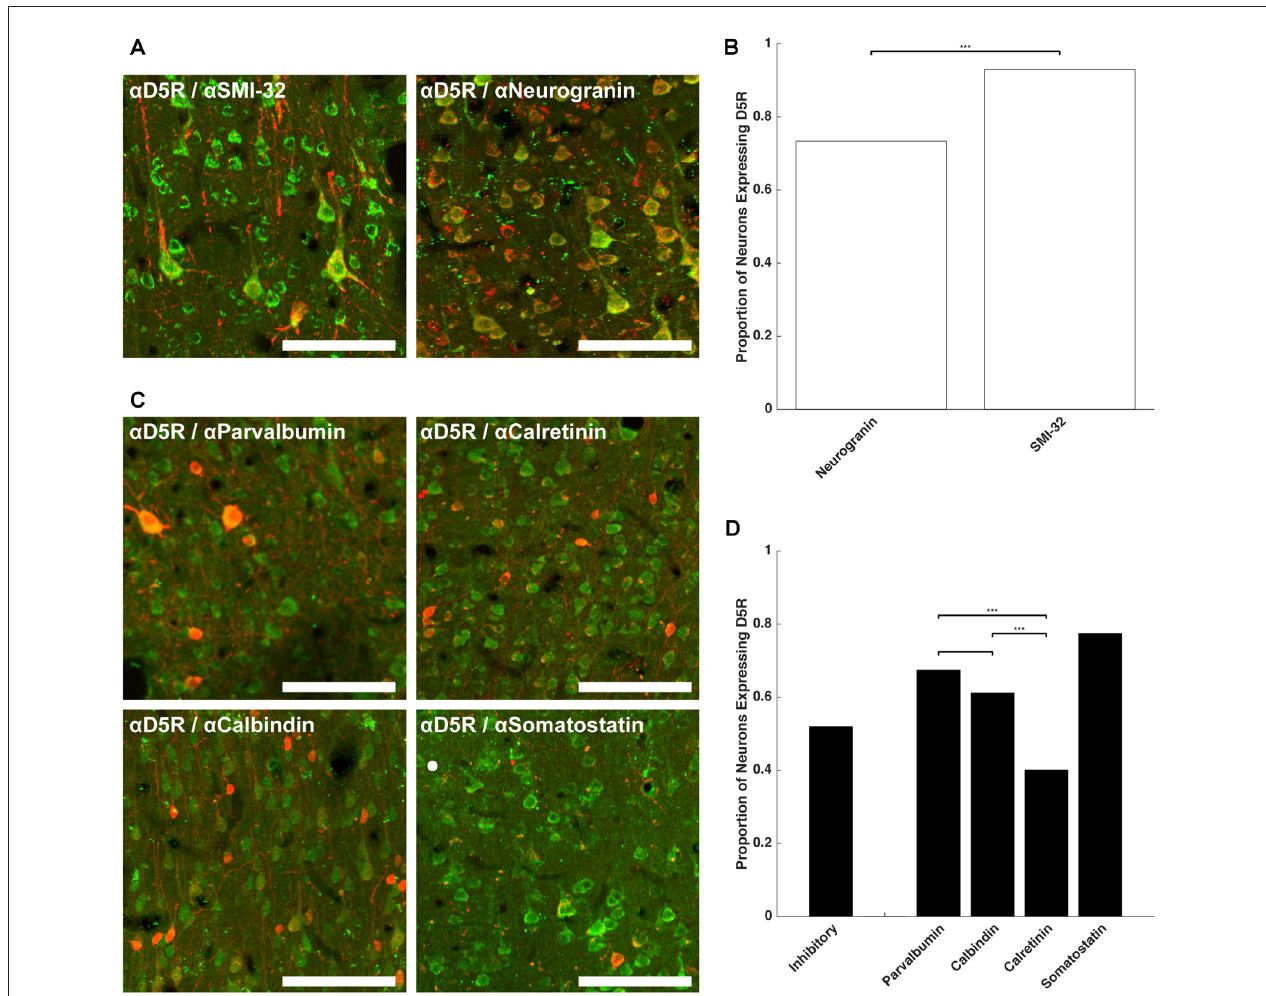
FIGURE 2 | D5R expression on different cell types. (A) Co-expression of D5Rs (green) and SMI-32+ putative long-range projection pyramidal neurons (red; left) and co-expression of D5Rs with a general pyramidal neuron stain (neurogranin, red; right). (B) Proportion of frontal eye field (FEF) SMI-32+ and Neurogranin+ neurons that express D5Rs. (C) Expression of D5Rs (green) among different interneuron subtypes (red): parvalbumin+ (top left), calretinin+ (top right), calbindin+ (bottom left), somatostatin+ (bottom right). (D) Proportion of inhibitory interneurons that express D5Rs. Statistical comparisons were made between parvalbumin+, calbindin+ and calretinin+ neurons. Somatostatin+ neurons were excluded because they were too sparse to be used in statistical comparisons. For all panels: scale bar is equal to 100 µ m and ∗∗∗ denotes significance at the level p ≤